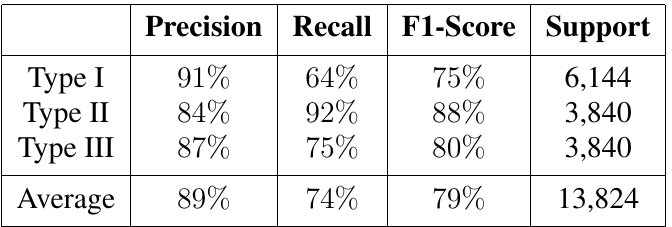
Table 4: Detailed Report for Multi-Label